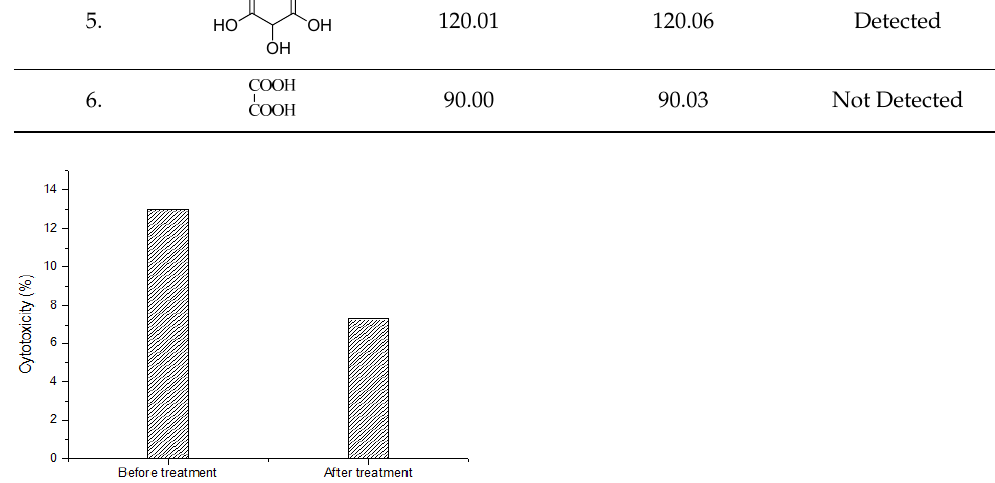
Figure 11. Cytotoxicity analysis of Reactive Yellow 160A before and after treatment (TiO 2 = 450 mg/L, RY ‐ 160A = 30 mg/L, H 2 O 2 = 0.8 mL, irradiation time = 120 min).